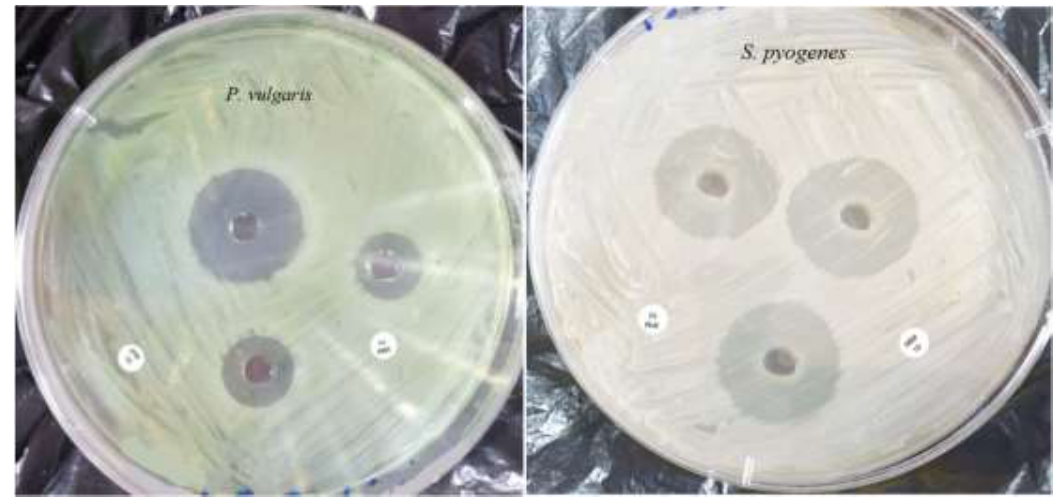
Figure 6: Antibacterial activity of Al data for p.vulgaris and AgNO3 NPs at p< 0.01and p < 0.05.